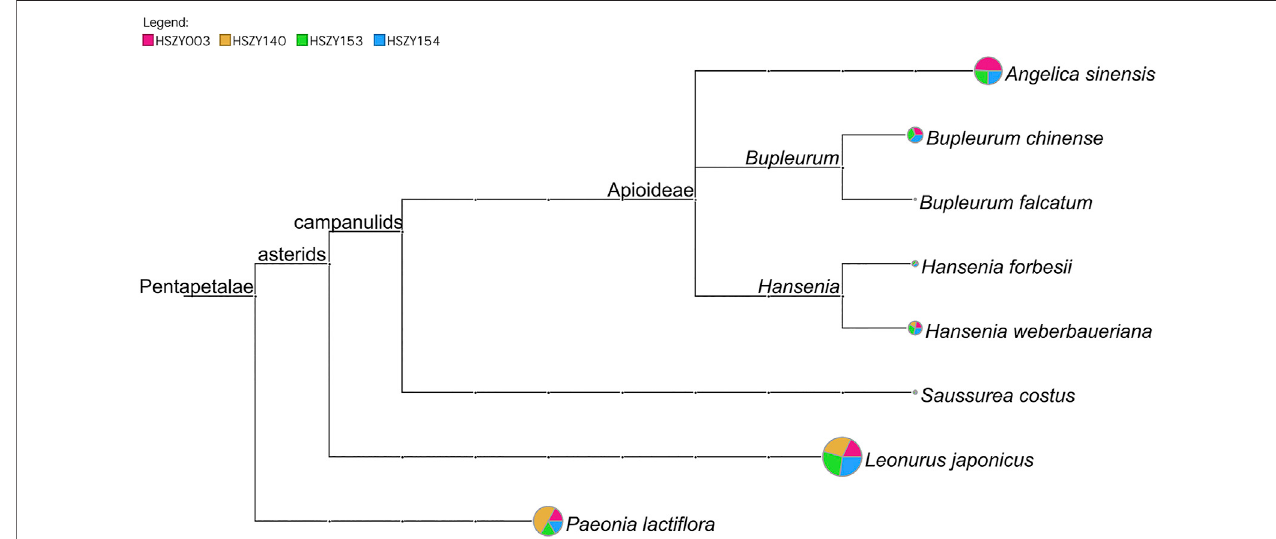
FIGURE 2 | A comparison of the taxonomic analytical results of the prescribed biological ingredients in four commercial FKDSW samples based on ITS2 sequences. Each taxonomic node represents a taxon in the NCBI taxonomy and is labeled according to its name. The pie chart shows the ratio of shotgun reads assigned to the corresponding taxon in four samples, while the size of the circle is scaled logarithmically to indicate the number of shotgun reads assigned to the taxon.